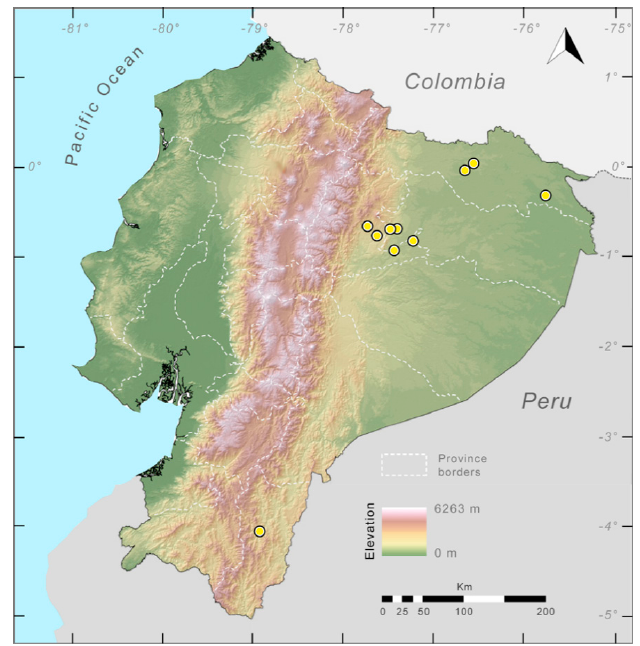
Figure 94. Distribution of Espadarana durrellorum in Ecuador (yellow dots).